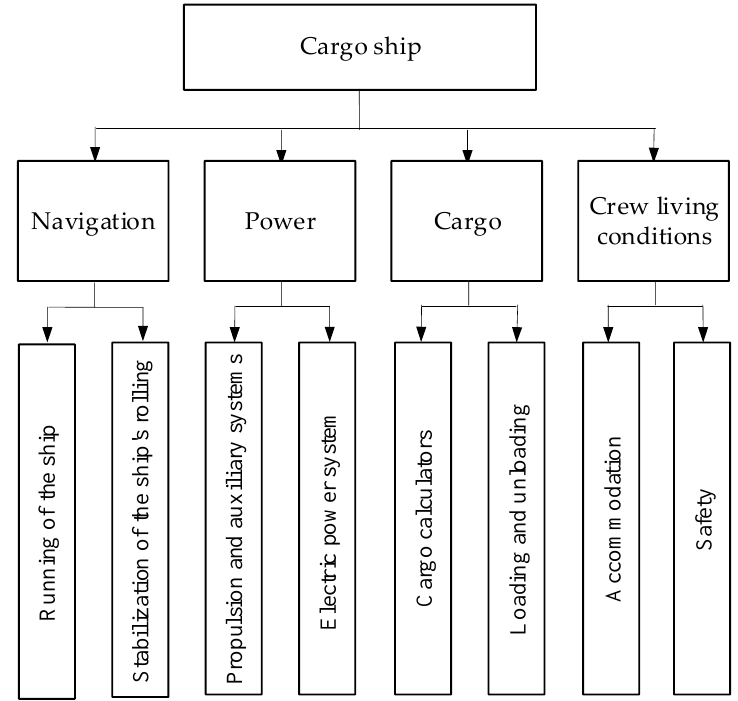
Figure 1. Systems and subsystems of typical cargo ship. (Updated version based on [2]).